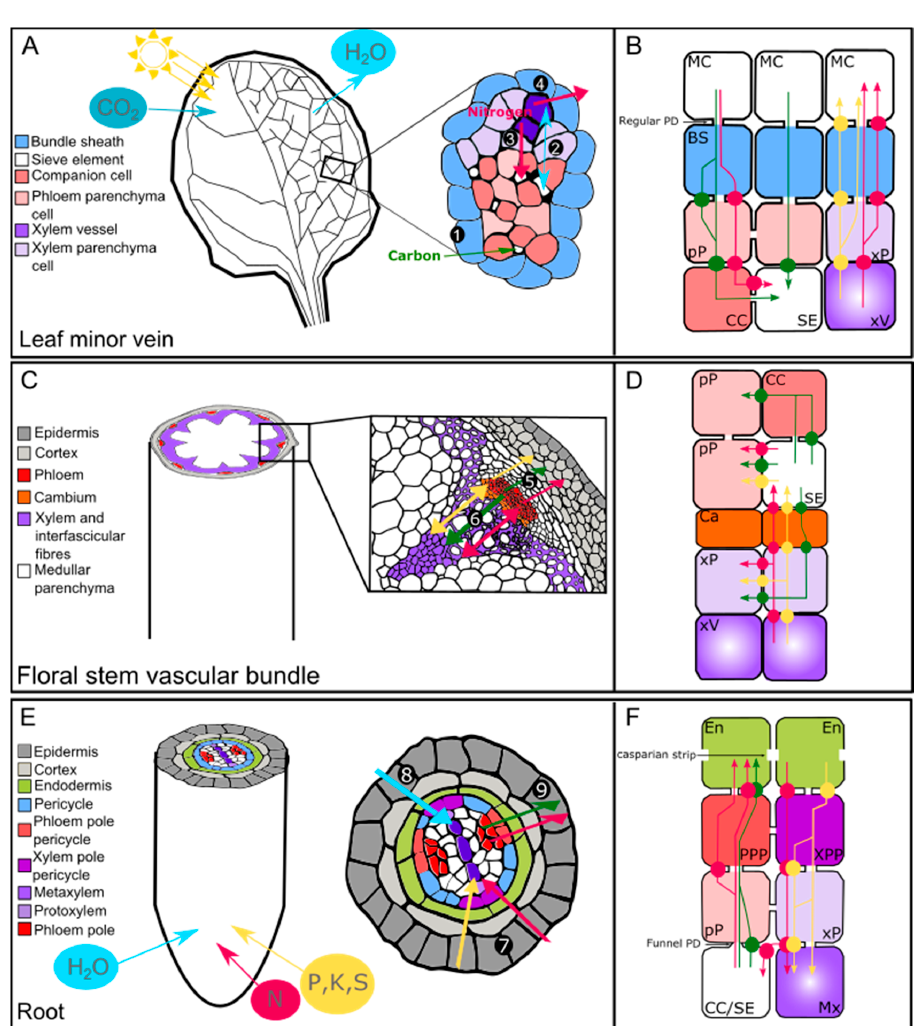
Figure 1. Organic and inorganic solutes take several paths to enter and exit the plant vascular system. This scheme is based on the Arabidopsis thaliana anatomy. ( A , C , E ) Schematic representation of a source organ (source leaf) ( A ), a transport organ (floral stem) ( C ), and a sink organ (root) ( E ). ( B , D , F ) Schematic representation of the possible transport pathways taken by the organic and inorganic solutes between the different cell types in each organ (( B ): leaf; ( D ): floral stem; and ( F ): root). 1. Loading of carbohydrates, organic acids, and amino acids in the sieve tubes. 2. Water flow between xylem and phloem. 3. Lateral transfer of amino acids from xylem to phloem. 4. N metabolism and N remobilization. 5. Leakage and retrieval of carbohydrates, amino acids, and ions between the phloem and the surroundings tissues. 6. Unloading of carbohydrates, organic acids, amino acids, and ions for the supply of metabolic precursors for cell division and expansion. 7. Uptake, efflux, and influx of inorganic solutes (e.g., NO 3 − , PO 43 − , K + , SO 42 − ) and nitrogen to the xylem. 8. Absorption and flow of water to the xylem. 9. Unloading of carbohydrates, organic acids, and amino acids that will later be used as precursors for cell division and expansion. The light blue, pale yellow, pink, and green arrows represent the water, inorganic solutes, nitrogen, and sugar movement, respectively. The circles represent the transporter-mediated movement of organic and inorganic solutes. BS: bundle sheath; CC: companion cell; En: endodermis; PD: plasmodesmata; Ph: phloem; pP: phloem parenchyma cell; PPP: phloem–pole pericycle; Px: protoxylem; MC: mesophyll cell; Mx: metaxylem; SE: sieve element; xV: xylem vessel; xP: xylem parenchyma cell; XPP: xylem-pole